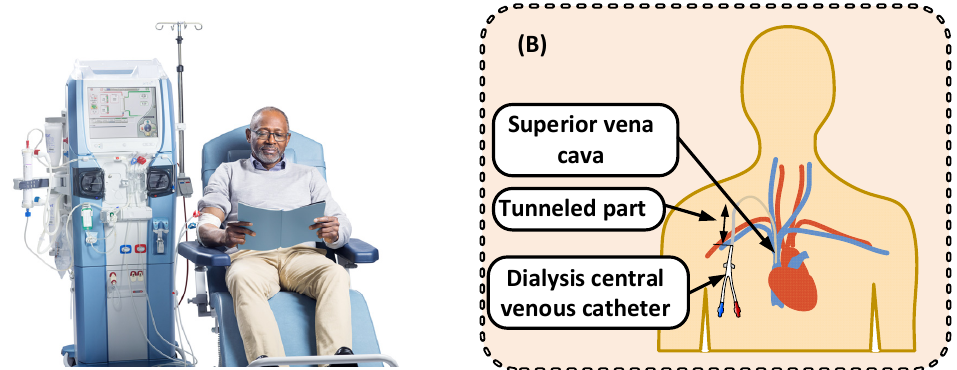
Figure 3. ( A ) Hemodialysis is the choice of renal replacement therapy, typically performed with a blood access in the arm (a fistula), for most patients that needs therapy for end stage renal disease, and in 2010 more than two million patients received dialysis treatment [46]. The treatment is generally well-tolerated with minor side effects [47]. ( B ) A tunneled central dialysis catheter is also used for chronic patients but also for temporary access to the blood. It allows for long-term access to the vein and is bidirectional, allowing flows in and out at the same time.